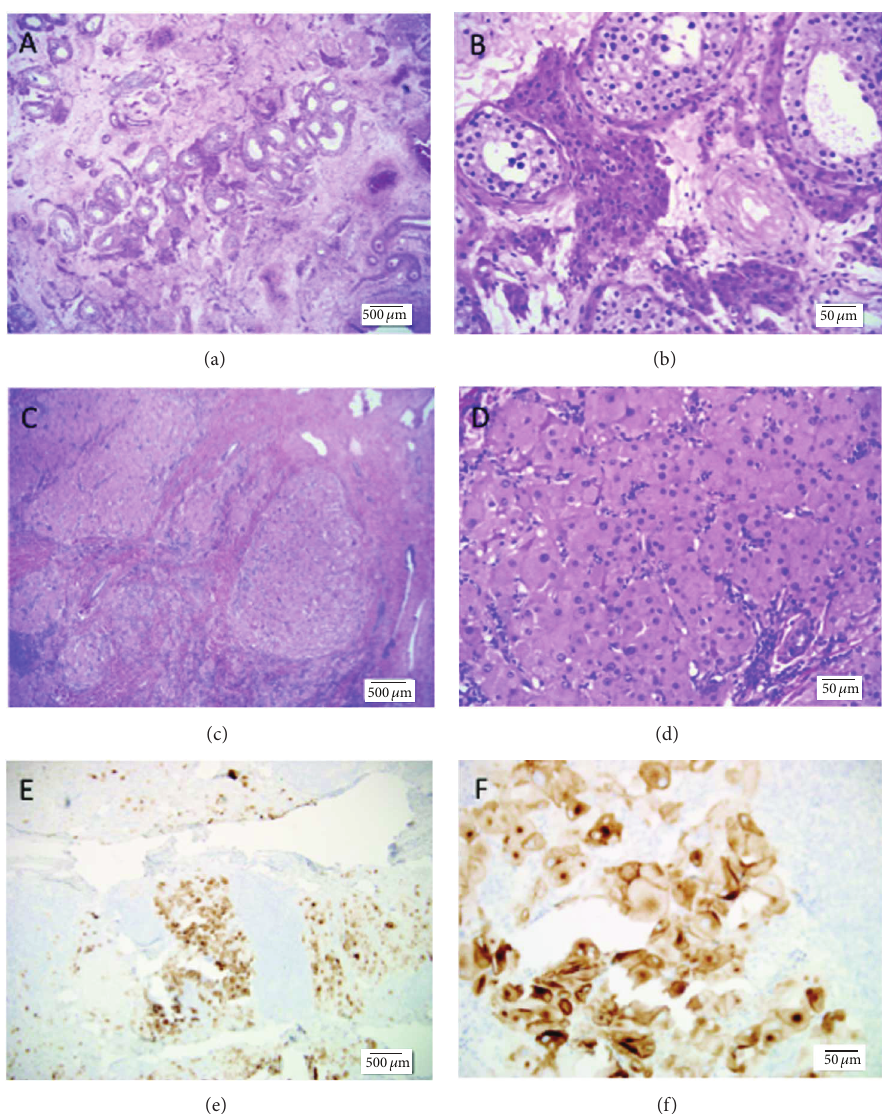
Figure 1: Morphology and IHC of the right testicular hilar tumor. (a) Uninvolved testis, H&E, 40x. (b) Uninvolved testis, H&E, 200x. (c) Testicular hilar tumor, H&E, 40x. (d) Testicular hilar tumor, H&E, 200x. (e) Testicular hilar tumor, synaptophysin, 40x. (f) Testicular hilar tumor, synaptophysin,